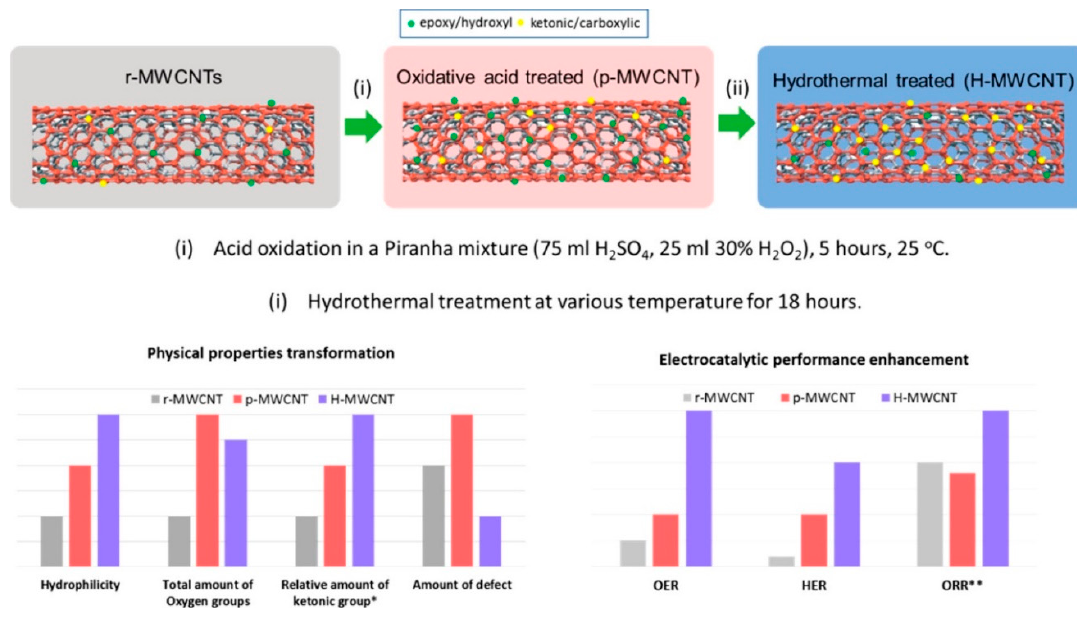
Figure 8. Graph of the effect of the hydrothermal treatment method on the change in physical properties and improvement in electrocatalytic performance (values on the graph for demonstration purposes). Indication: * ketonic group has been demonstrated to catalyze a number of electrochemically important reaction such as OER and HER, ** the ORR performance of r-MWCNT was found to be higher due to the presence of surface bound metal impurities. Adapted from [137], with permission from ACS Applied Materials & Interfaces , 2016.